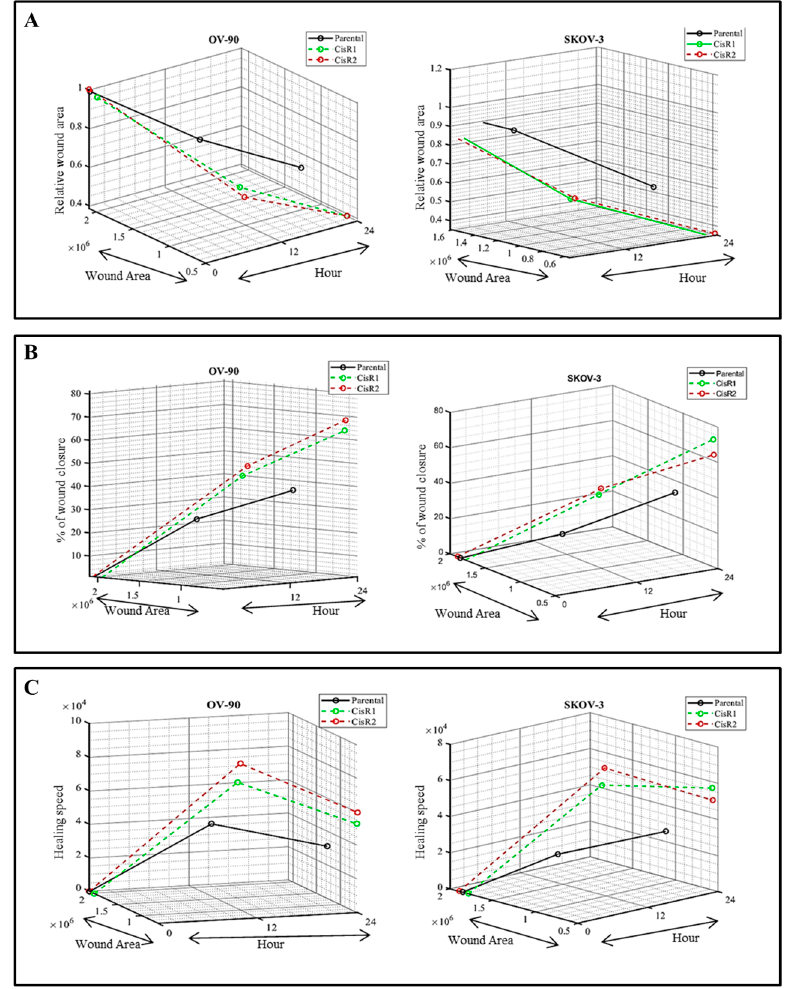
Figure A2. The cell migration capacity of parental and CisR OC cells predicted by ANN. (A) The relative wound area; (B) % of wound closure; (C) Healing speed.